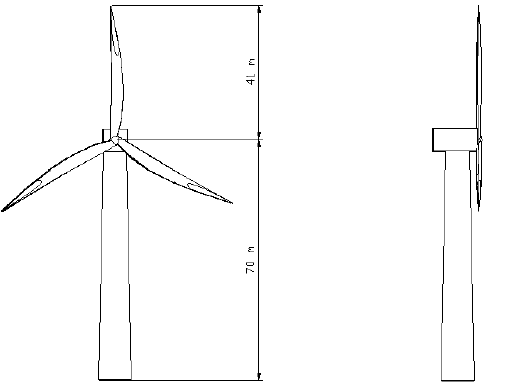
Figure 1. Dimensions of the wind turbine [7].